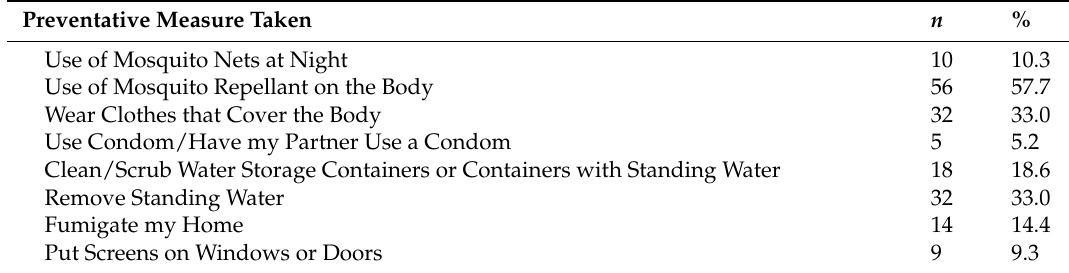
Table A2. Itemized analysis of preventative measures for Zika transmission among Latinas of childbearing age in South Florida 2017–2018 ( n =